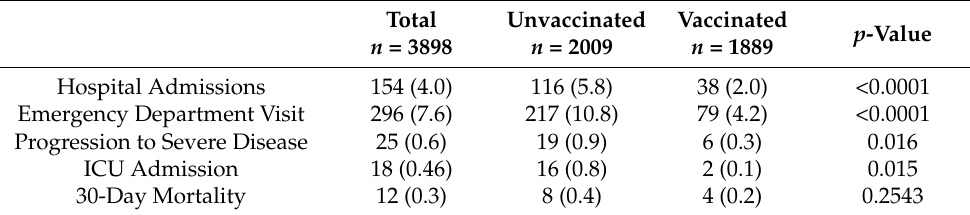
Table 3. Patient Outcomes, n (%).